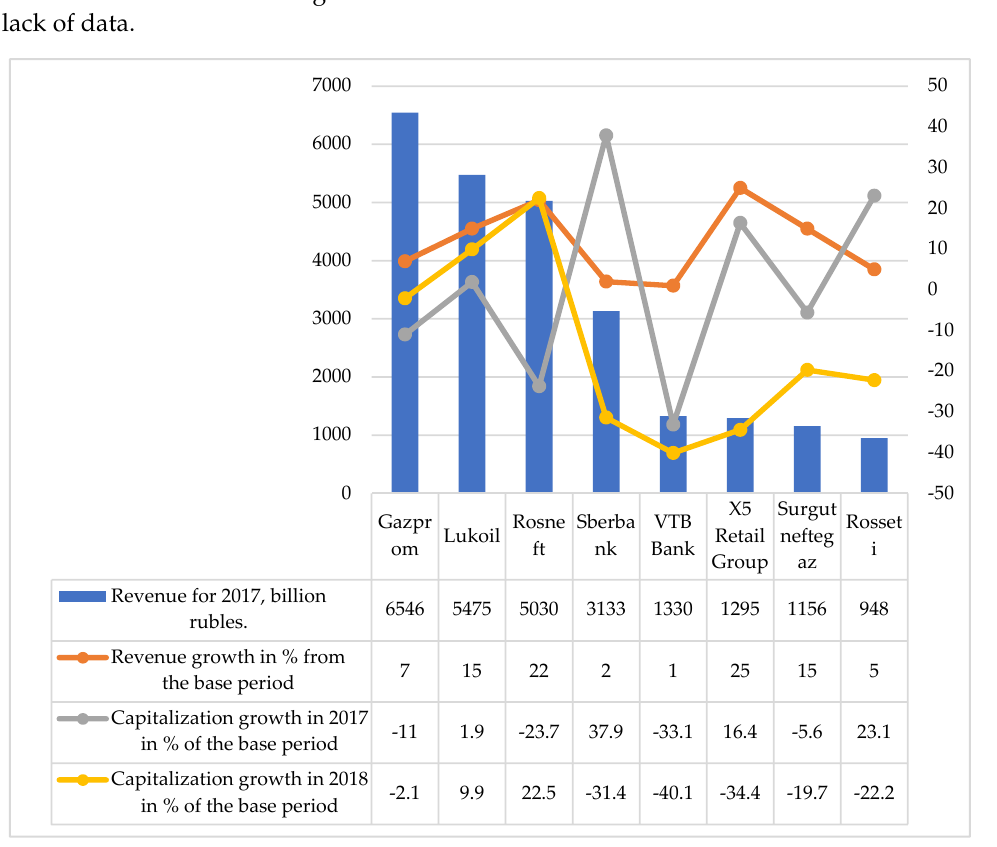
Figure 1. The most successful Russian issuers in 2017–2018. Compiled by the authors on the basis of Centralnyj Bank RF: Oficialnyj sajt (2021); Gavrilova (2021); Gavrilova (2019); Kommersant (2020).